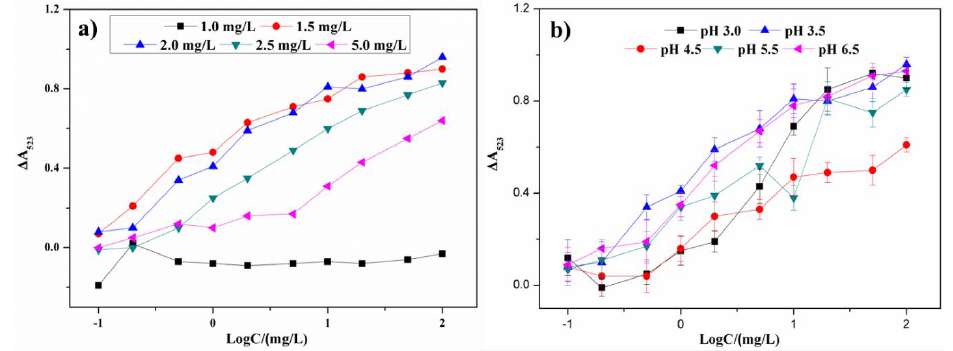
Figure 5. The plots of ΔA523 versus metsulfuron-methyl concentration under ( a ) different concentration of melamine and ( b ) different pH conditions (pH 3.0, pH 3.5, pH 4.5, pH 5.5, and pH 6.5).